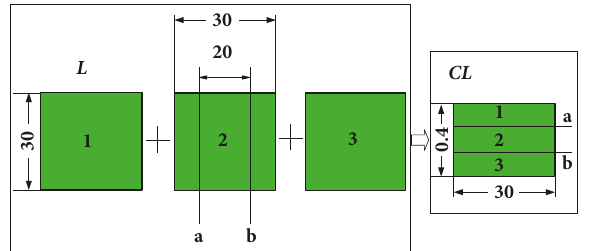
Figure 2: Fabrication of the absorbent body CL: L, microfiber cloth; 1 and 3, microfiber cloths without copper electrodes; 2, microfiber cloth with copper electrodes a and b. The values of the lengths are in mm.